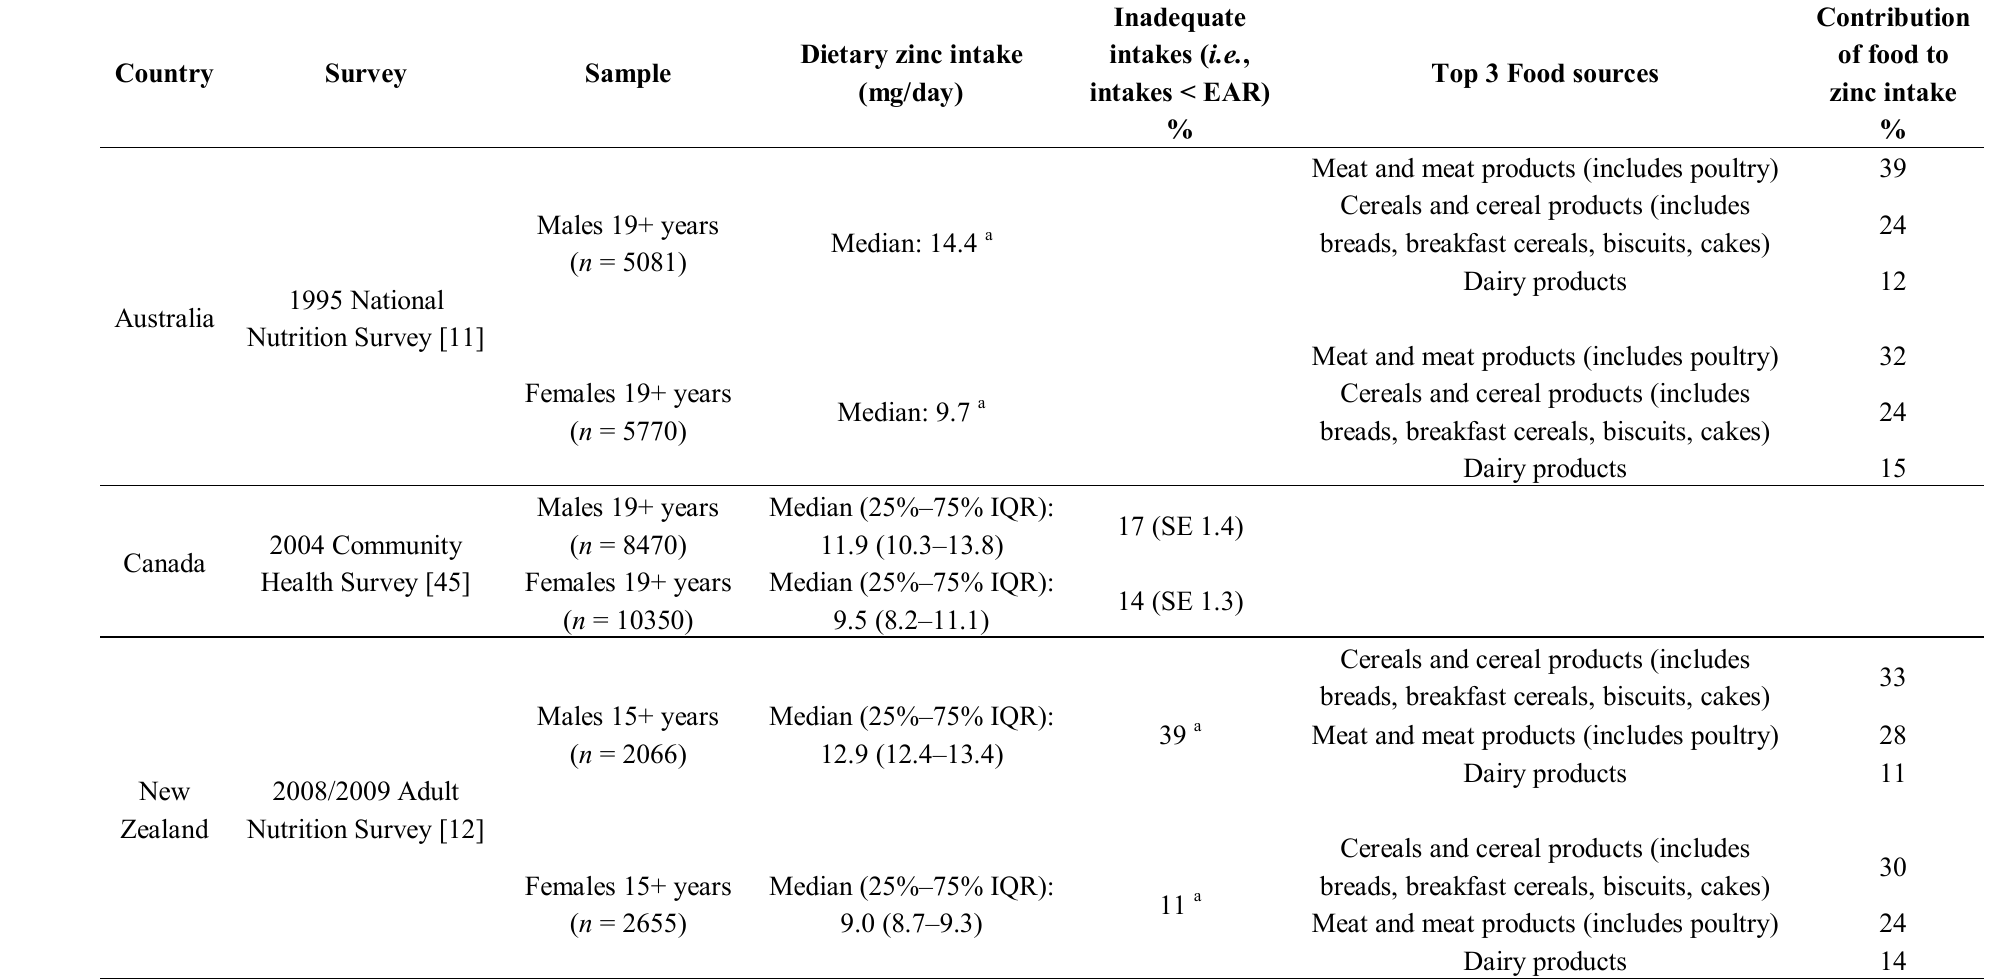
Table 3. Intakes, adequacy, and top food sources of dietary zinc in economically-developed